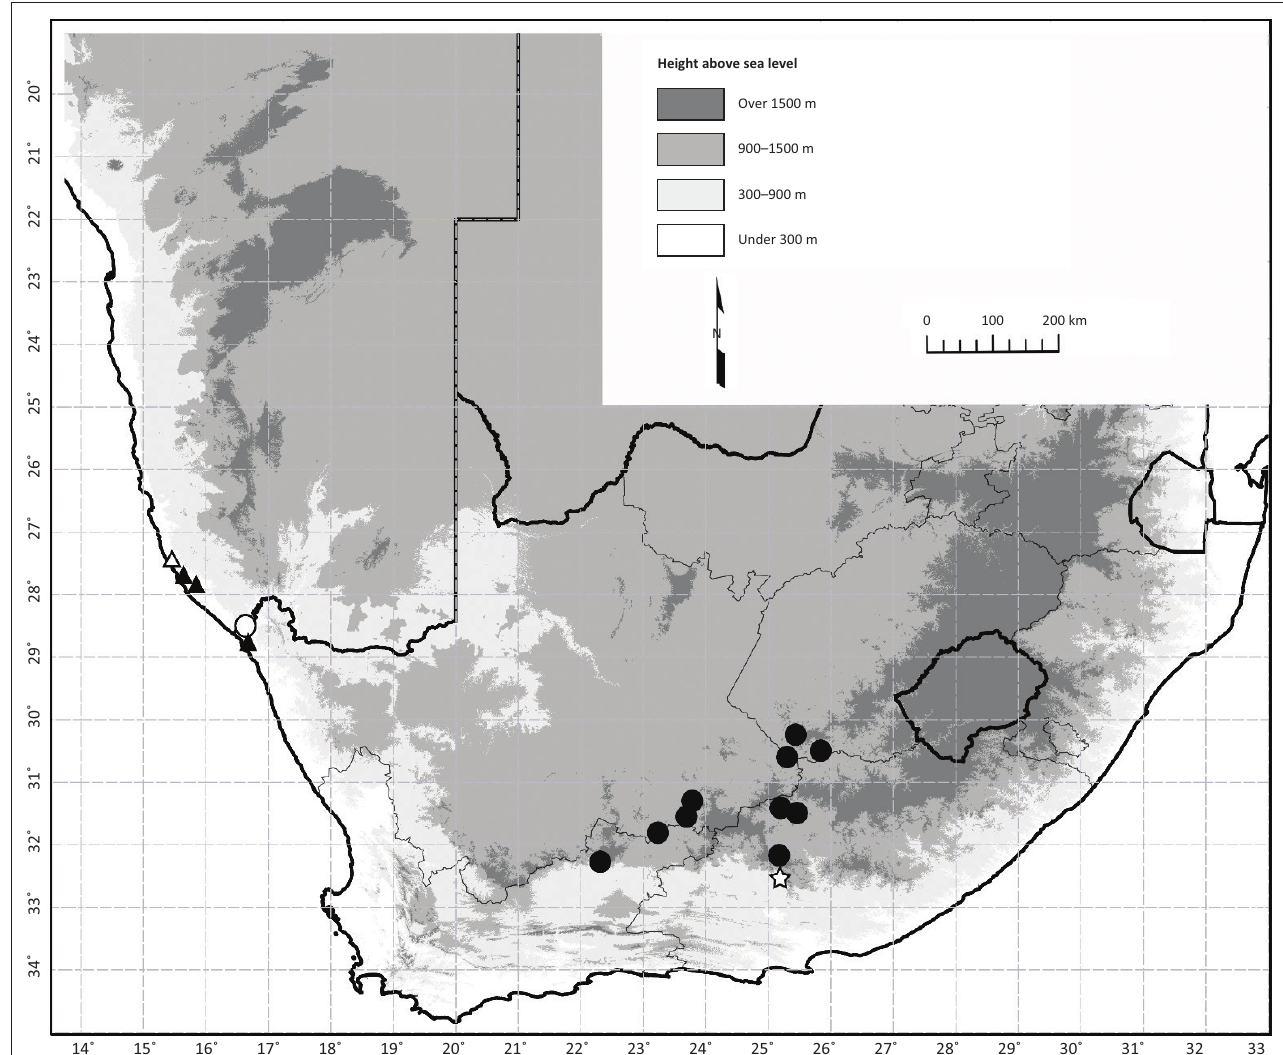
FIGURE 1: Distribution of Lasiosiphon microphyllus (●) and L. suavissimus ( ▲ ). The type localities of L. microphyllus (○), L. suavissimus (∆) and L. kuntzei (  ) are also